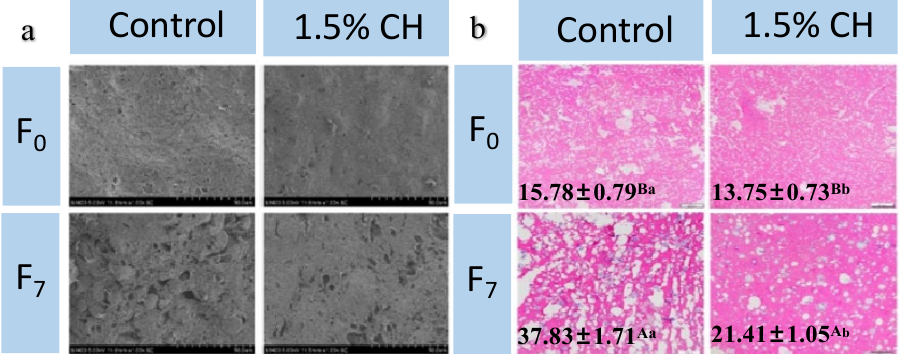
Figure 3. Influence of chitosan ice coating on the scanning electron microscopy (SEM) images ( a ) and optical microscope images ( b ) of fish balls induced by freeze–thaw cycles (magnification: 1000 × ). F 0 : 0 freeze–thaw cycle; F 7 : 7 freeze–thaw cycles. Means with different capital letters in the same treatment group (A–B) differed significantly ( p < 0.05); means with different lowercase letters in the same freeze–thaw cycle (a–b) differed signif-icantly ( p <